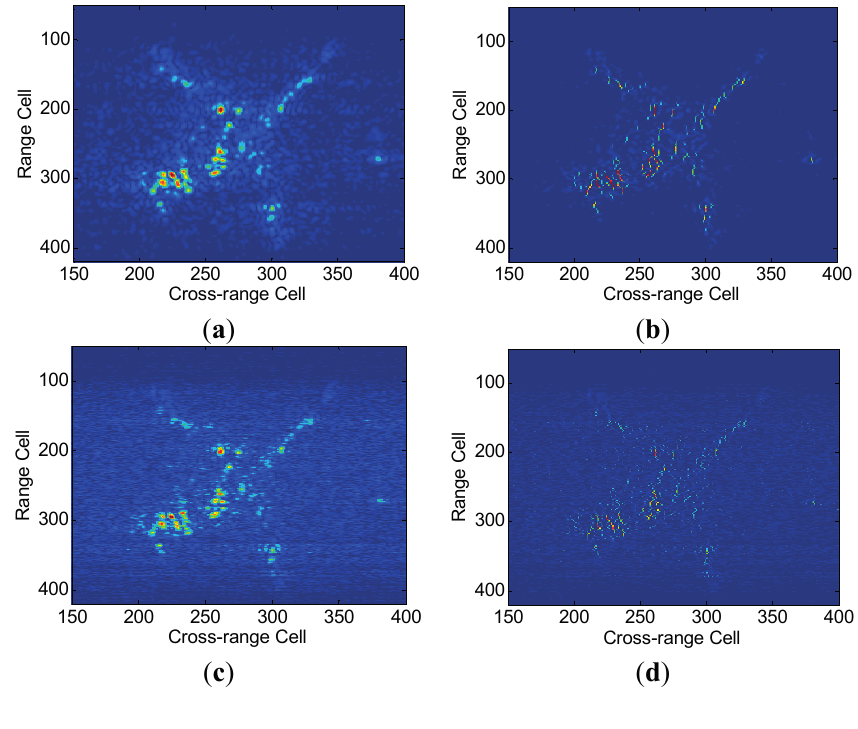
Figure 7. ( a ) Range profiles via IFFT method; ( b ) Range profiles via SR method; ( c ) Range profiles via SR method with range alignment; ( d ) Range profiles by FFT transform on FSI method formulated ISAR